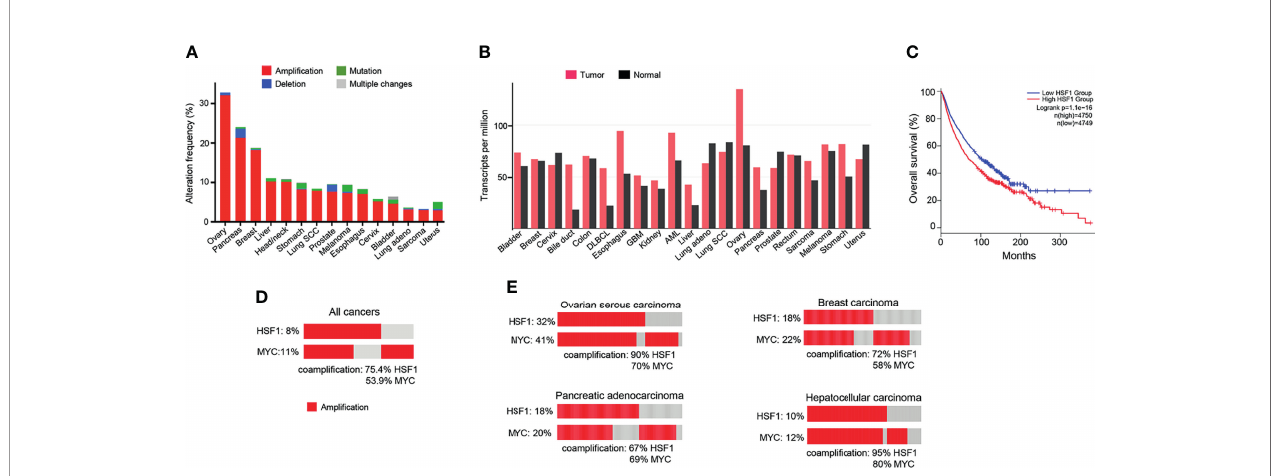
FIGURE 3 | HSF1 alterations in human cancers. (A) Frequency of HSF1 gene alterations in major human cancers. HSF1 gene is more commonly ampli fi ed than mutated in malignancies. Data source: curated set of all studies available (as of January 2022), accessed and analysed through cBioPortal (cbioportal.org) (165, 166). (B) HSF1 mRNA levels in cancer and corresponding normal tissue across common cancer types. Data was accessed and analysed through GEPIA (gepia.cancer- pku.cn) (25). (C) Kaplan-Meier graph demonstrating the impact of combined alterations in HSF1 gene on overall survival in a pan-cancer analysis (log-rank p- value=1.1e -16 ). Data were accessed and analysed through GEPIA (gepia.cancer-pku.cn) (25). (D) Oncoprint of genetic alterations in HSF1 and MYC genes in a pancancer analysis (n=14107). (E) Ampli fi cation and coampli fi cation of HSF1 and MYC genes in ovarian serous carcinoma (n=311), invasive breast carcinoma (n=1169), hepatocellular carcinoma (n=596) and pancreatic adenocarcinoma (n=1846) (cbioportal.org) (165,